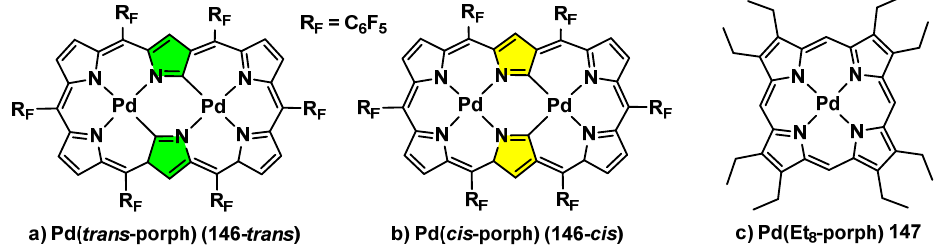
Figure 40. Molecular structures of palladated ( a ) 146 ‐ trans - and ( b ) 146 ‐ cis -hexaphyrines, NIR-III emitters [132]; ( c ) structure of Pd(Et 8 -porph) 147 , whose phosphorescence can be tuned to fluorescence by action of Ag-nanoprisms [133]. Adapted from [132,133].